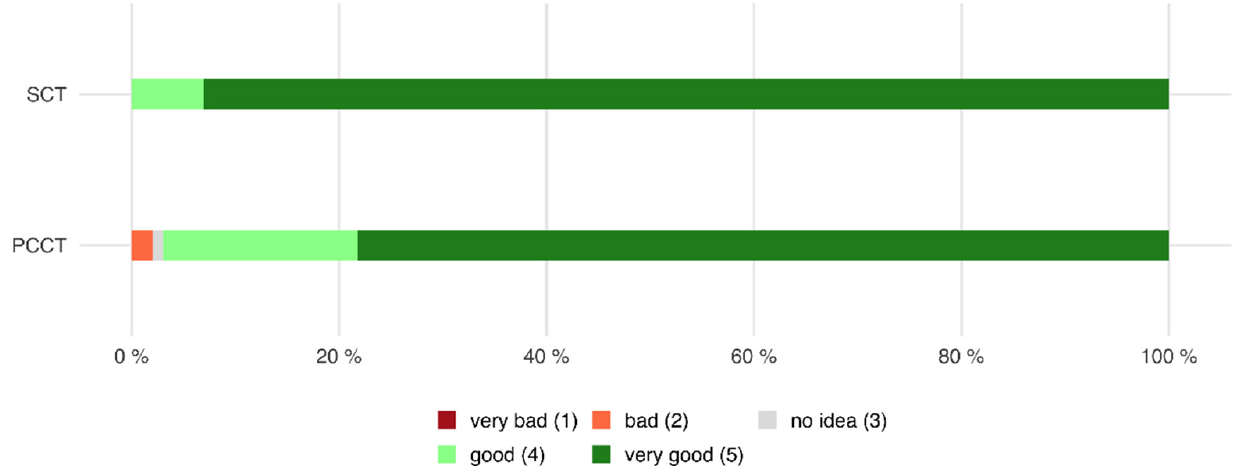
Figure 9. Horizontal stacked bar chart showing the perceived communication during the CT examination. There was no significant difference between both scanners (PCCT 4.77 ± 0.5 versus SCT mean 4.93 ± 0.3, p = 0.075).